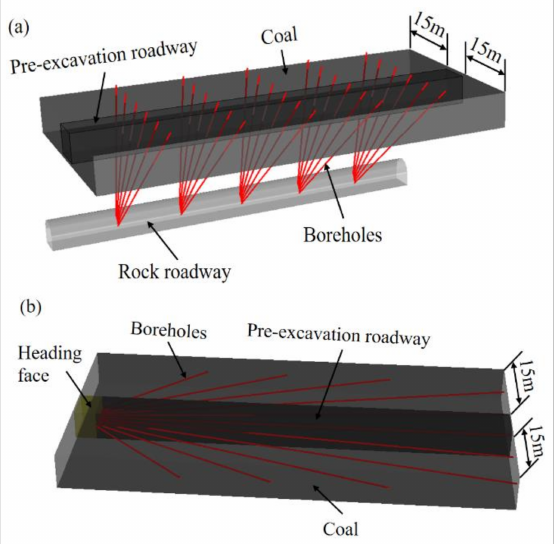
Figure 1. Schematic diagram of gas drainage technology in the heading face. ( a ) Cross-measure borehole gas drainage technology. ( b ) In-seam borehole gas drainage